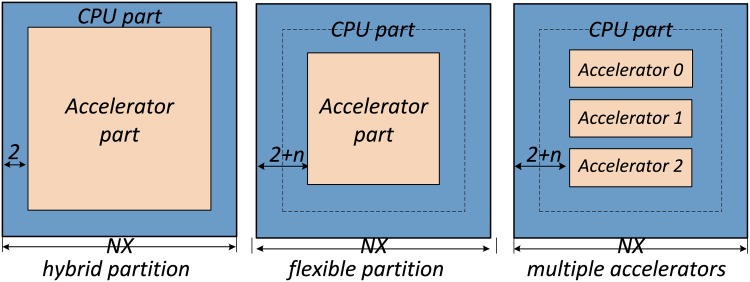
Our flexible partition scheme.